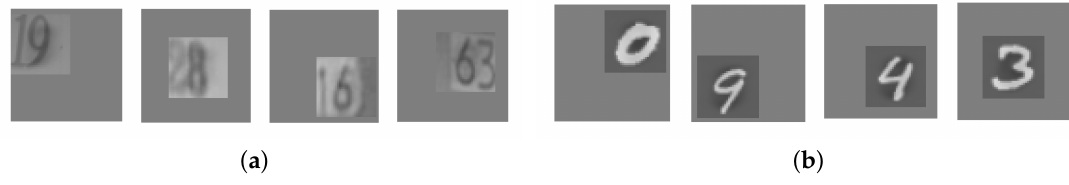
Figure 6. Examples of non-centered SVHN and MNIST datasets. ( a ) Random sample of non-centered labeled SVHN datasets; ( b ) Random sample of non-centered unlabeled MNIST